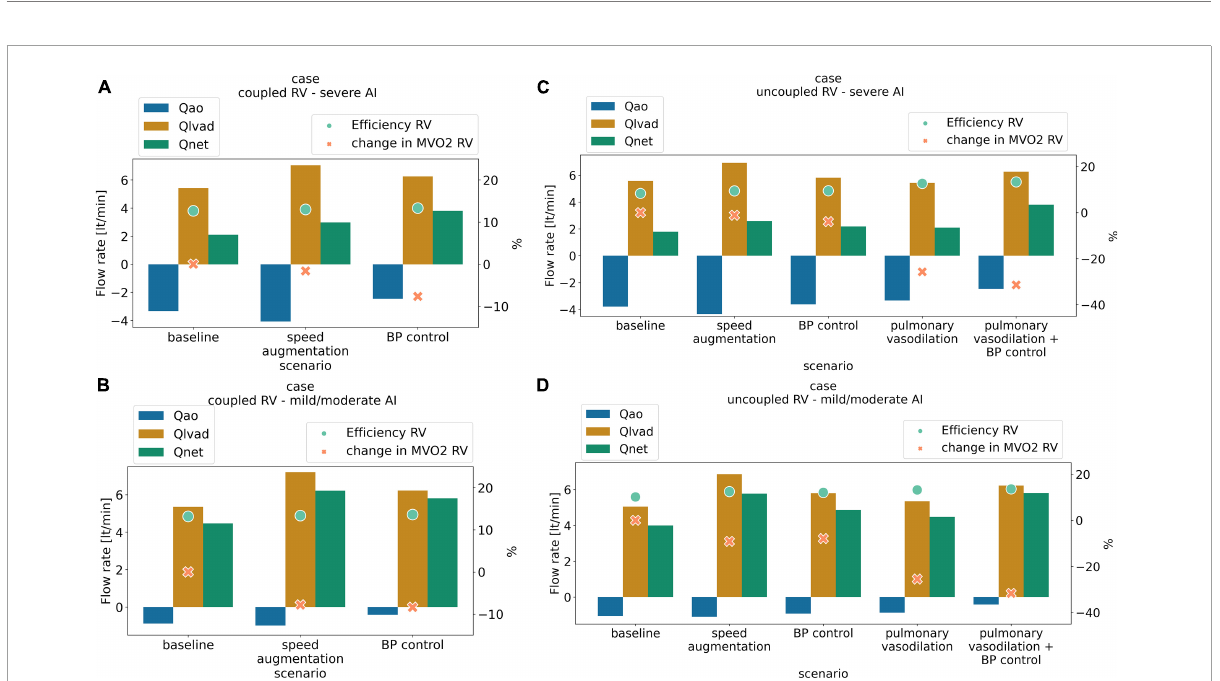
FIGURE1 Antegrade flow (L/min) (orange), retrograde flow (L/min) (blue) net flow (L/min) (green) right ventricular cardiac efficiency (%) (dot light green), and change in right ventricular oxygen consumption (%) (RV MVO2, cross light orange) with medical management and LVAD speed augmentation in a scenario of (A) coupled right ventricular (RV) with severe aortic insufficiency (AI), (B) coupled RV with mild/moderate AI, (C) uncoupled RV with severe AI, (D) uncoupled RV with mild/moderate